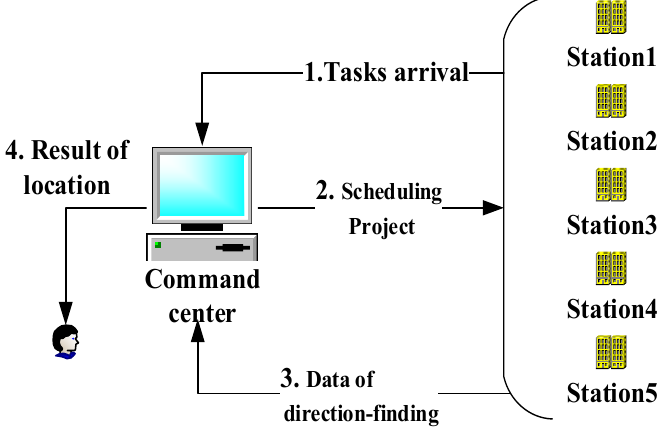
Figure 2. Architecture of a passive location system.